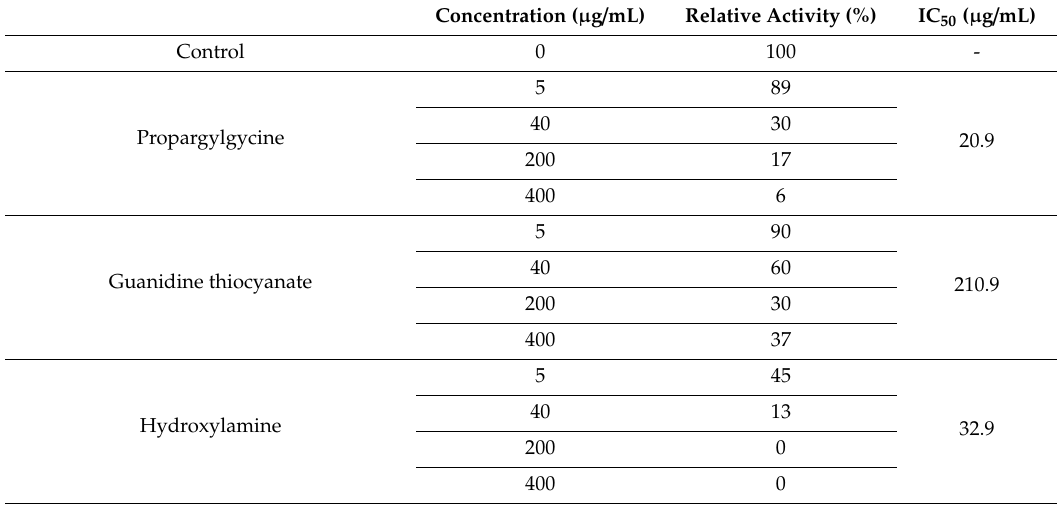
Table 5. E ff ect of di ff erent amino acids suicide analogues on the activity of A. terreus